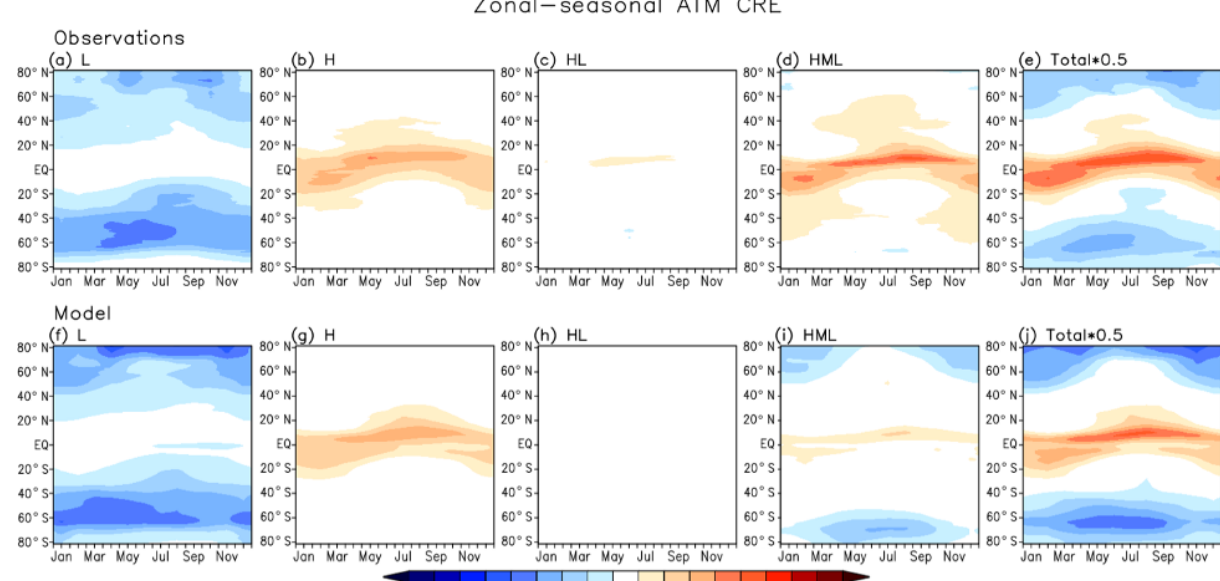
Figure 9. As Fig. 7, but for ATM total all-sky